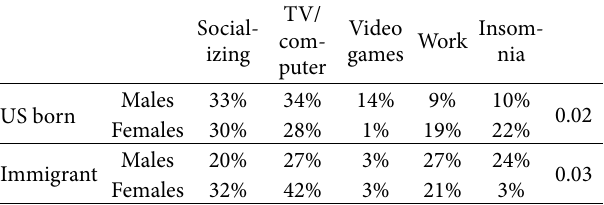
Table 2: Reasons for sleep debt based on gender and migrant